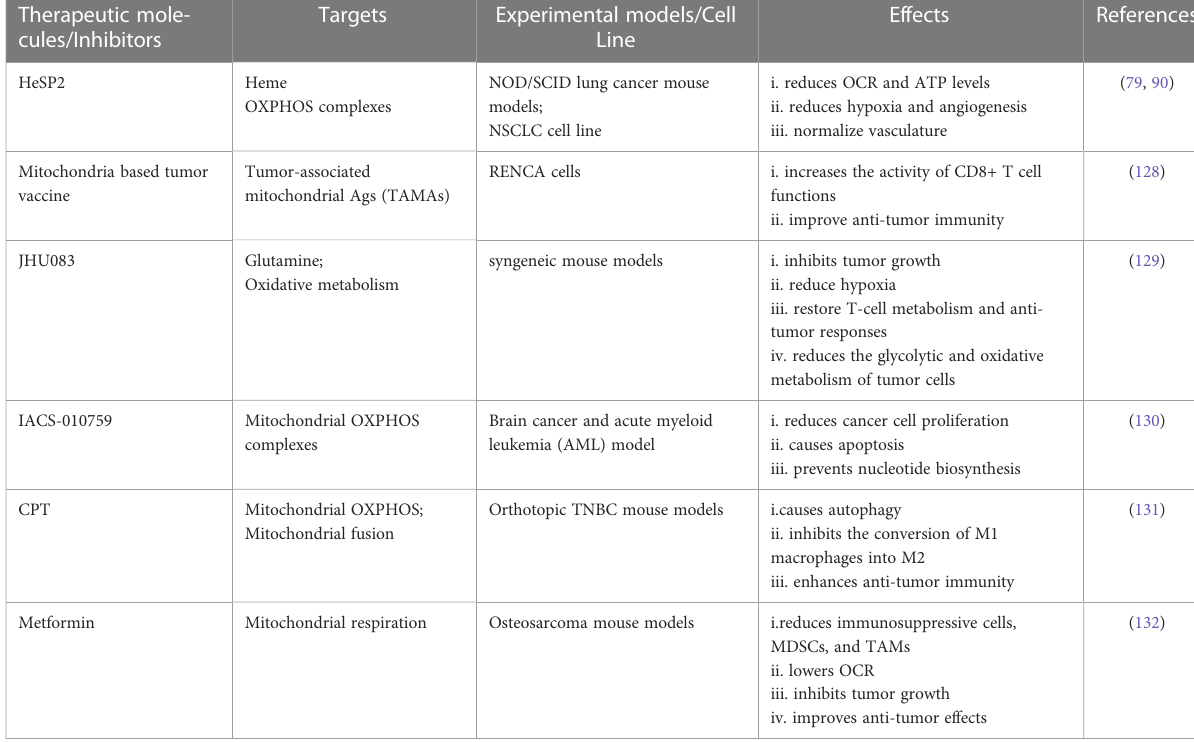
TABLE 2 Studies targeting mitochondrial respiration and OXPHOS complexes and their effects in TME and anti-tumor immunity. Therapeutic